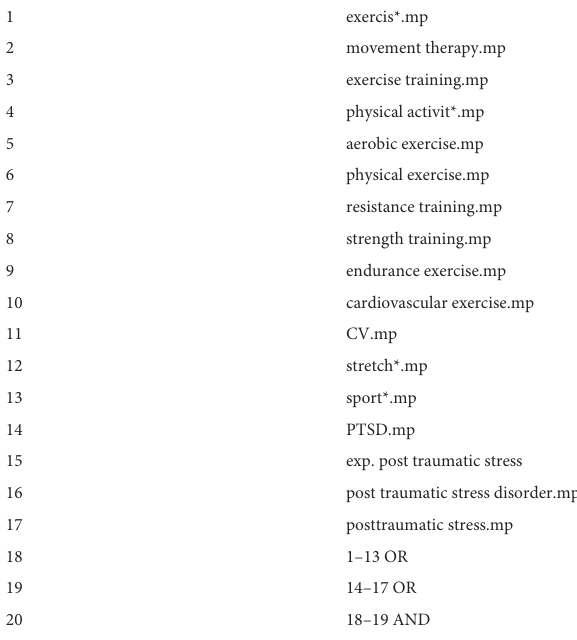
TABLE 2 Medline database search